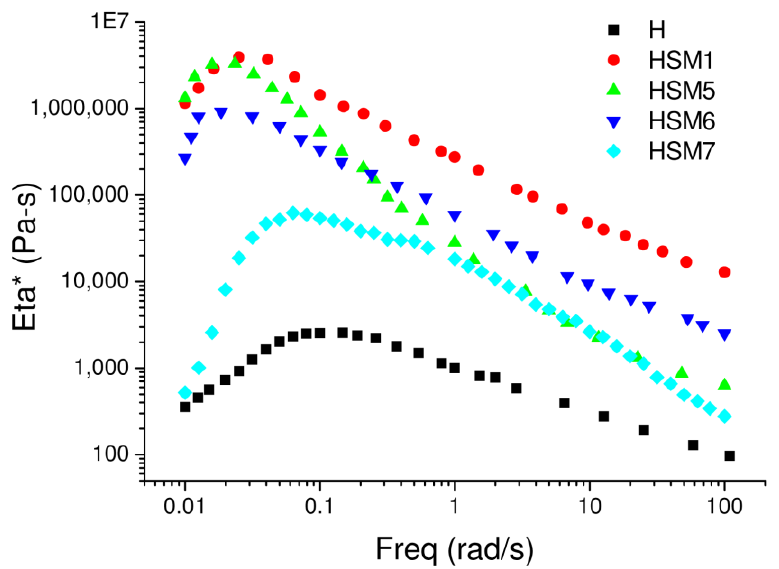
Figure 6. Complex viscosity ( η *) vs frequency of the reference sample (H) and all the HSMX coat- ings.